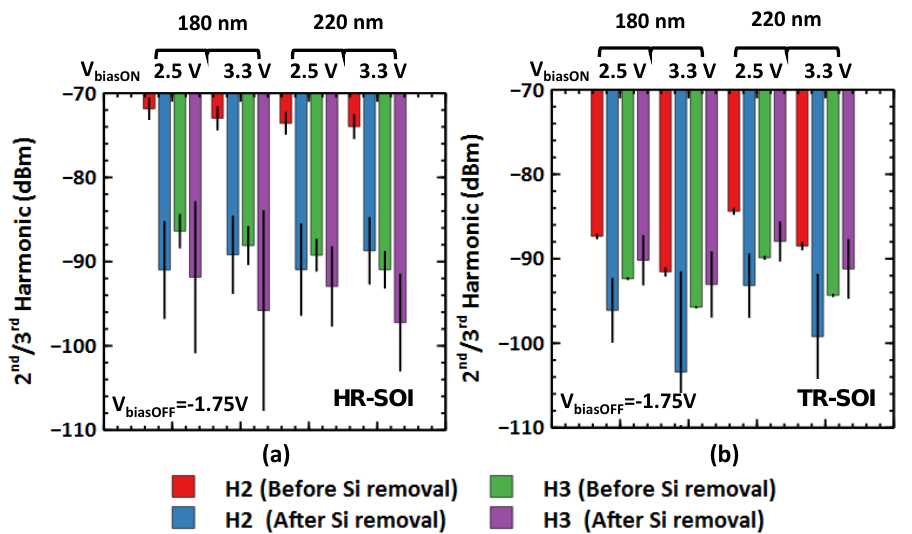
Figure 14. Second/third harmonic levels for different gate lengths (180 or 220 nm) and bias conditions (V biasON = 2.5 or 3.3 V, V biasOFF = − 1.75 V) before and after substrate removal: ( a ) HR-SOI substrate; ( b ) TR-SOI substrate.